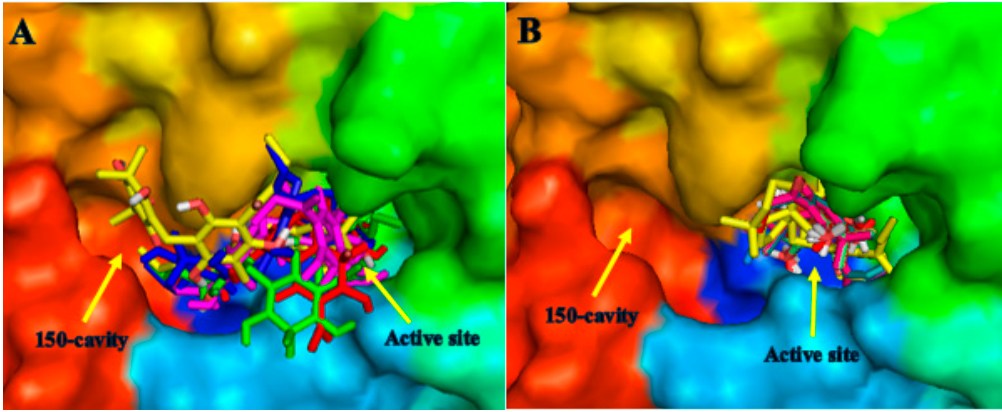
Figure 2. Binding modes of trimeric, tetrameric phloroglucinols ( A ) and monomeric, dimer phloroglucinols ( B ) in the active site and ‘150-cavity’ of NA.